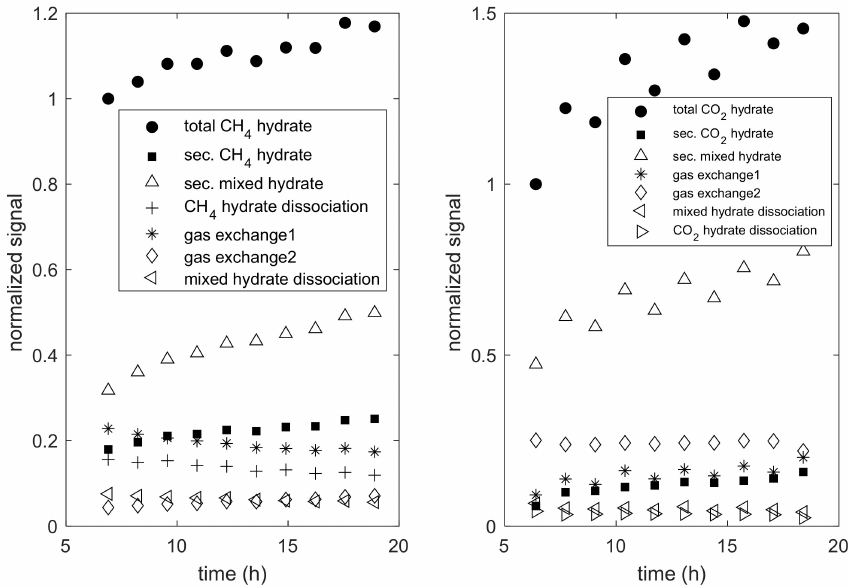
Figure 15. Evolution of the total gas hydrate signal during the flow period of experiment Flow and evolution of the specific processes. Left: CH 4 hydrate, right: CO 2